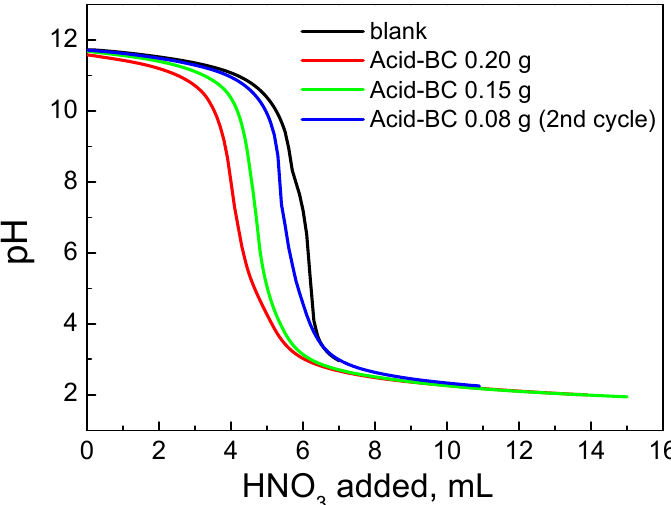
Figure 5. Titrations curves for the blank solution and two suspensions of biochar with 0.15 and 0.2 g. The third titration curve (blue line) corresponds to the second titration of a previously titrated sample after filtration and washing with ultrapure water.